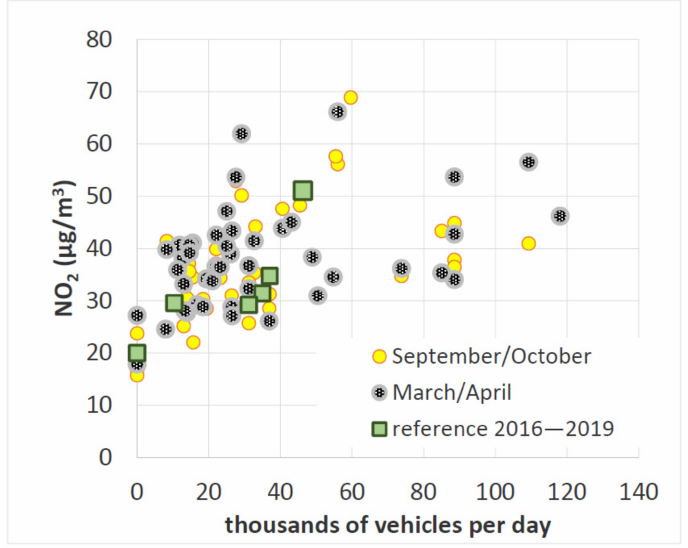
Figure 5. Relationship between traffic intensity and NO 2 concentrations measured by passive samplers in spring and fall of 2019 and by the national monitoring network (average of